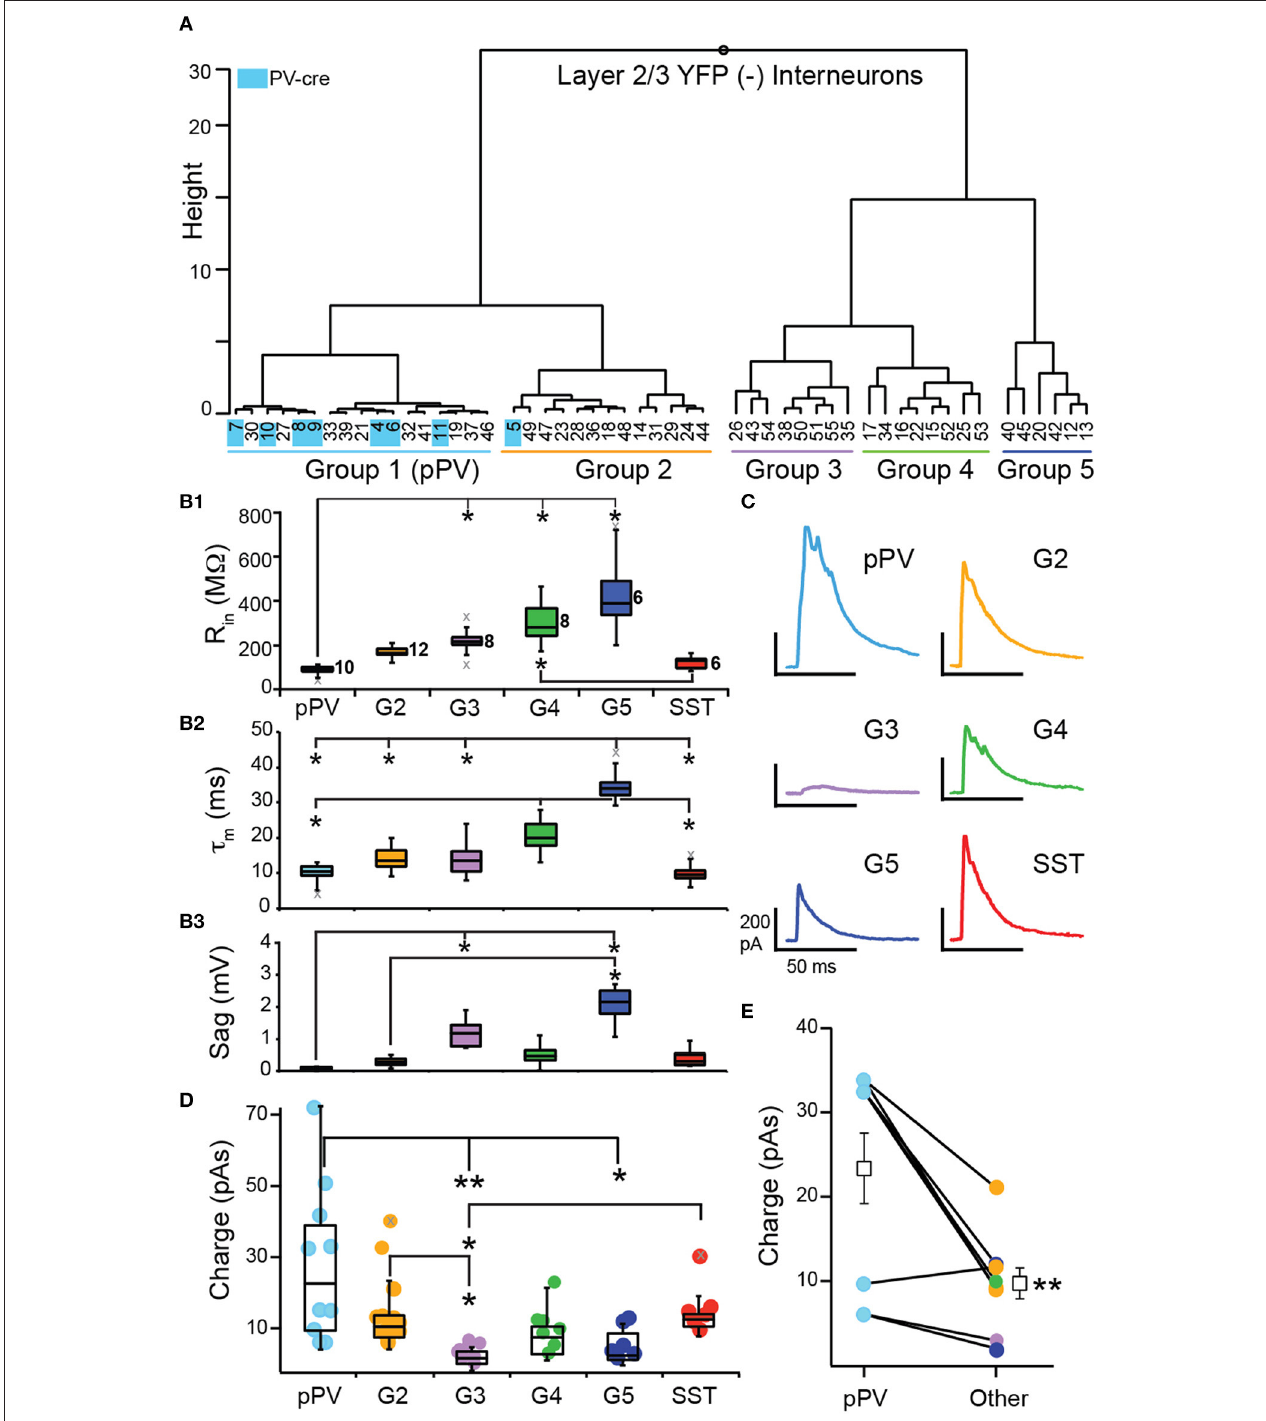
FIGURE 6 | Inhibition of L2/3 interneurons by SST-interneurons. (A) YFP( − ) interneurons were clustered according to subthreshold intrinsic properties into five groups (G1–G5). Identified PV-cre cells (indicated in blue) were included as benchmark neurons and clustered almost exclusively with G1. Thus, we denote G1 interneurons as pPV (blue). (B) Comparisons of subthreshold property distributions presented as median and quartiles (Q 1 , Q 3 ) between groups (pPV, G2–G5, and SST; * p < 0.05, KW-test) ( B1 ) input resistance ( R in ), (B2) time constant ( τ m ), and (B3) Sag. Gray x’s indicate outliers. (C) Representative IPSCs recorded in interneurons from each group. (D) Comparison of the distributions (median, Q 1 , Q 3 ) of IPSC strength taken as the area under the IPSC (Charge, pAs) across groups (* p < 0.05, ** p < 0.01, KW-test). (E) Mean IPSC strength was significantly greater in pPV cells compared to other interneurons (G2–G5) recorded in the same slice ( p < 0.01,